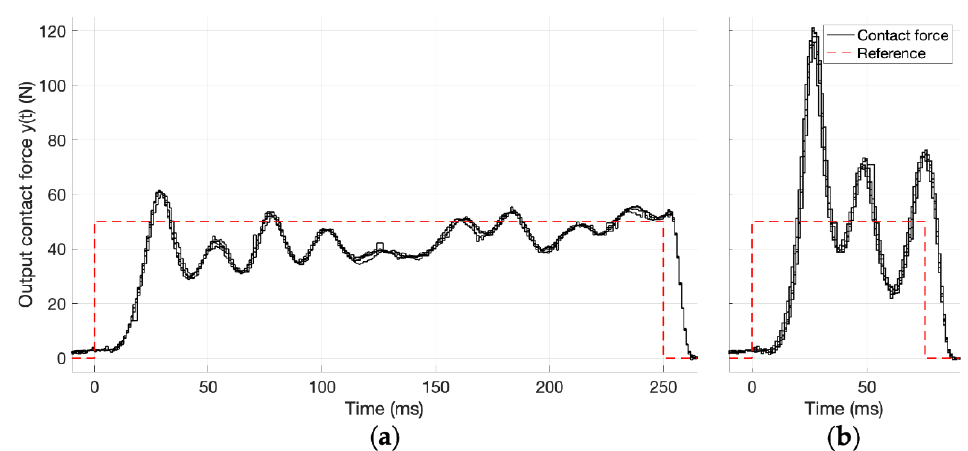
Figure 5. Force tracking of the MPC algorithm for the HIL: ( a ) refers to the R1 reference signal (50 N, 250 ms), ( b ) refers to the R2 reference signal (50 N, 75 ms). Reference force signal in red dashed lines, continuous lines refer to the output contact force obtained for different control parameters (see Table 5).